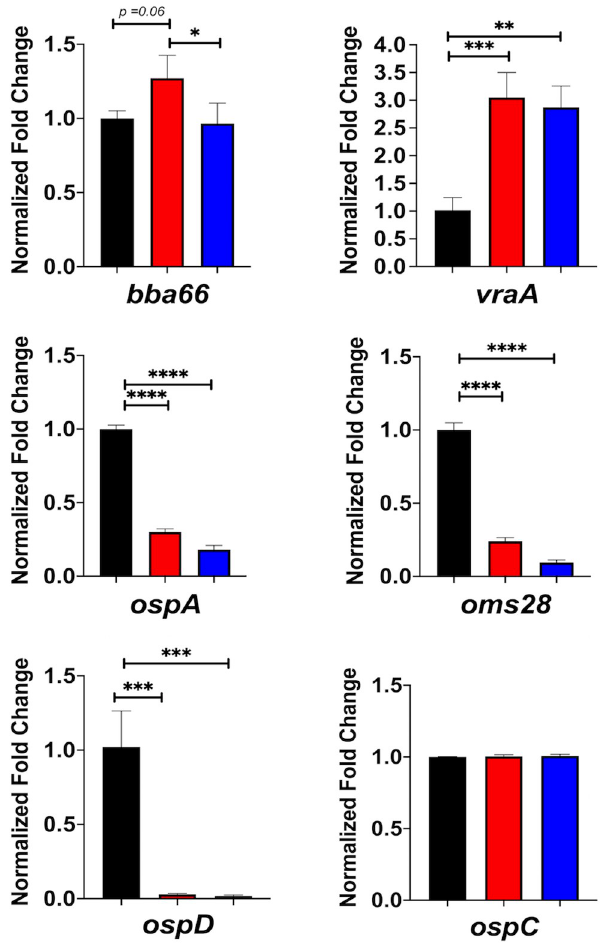
Fig 7. Quantification of transcripts by qRT-PCR. Quantitative RT-PCR (qRT-PCR) of the parent (black bars), ittA mutant (red bars), and complemented strain (blue bars) were performed for a subset of transcripts indicated at the bottom of each panel. The data for all samples were normalized to the endogenous control, flaB , whose transcription was not affected by the conditions used in the experiment. The error bars indicate standard error. Significance is denotated as � p < 0 . 05 , �� p < 0 . 01 , ��� p < 0 . 001 . ���� p < 0 . 0001 .